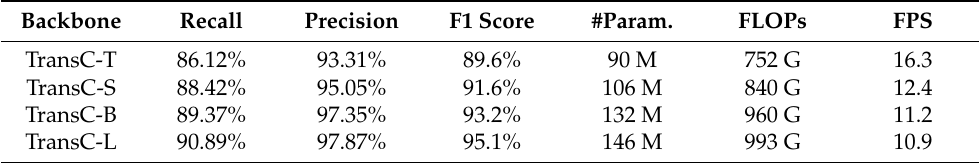
Table 3. Results of TransConvNet with four different capacities on VEDAI data set.